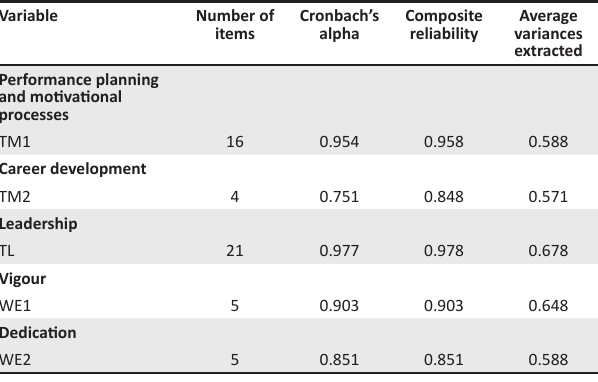
TABLE 1: Final model: Revised assessment of internal